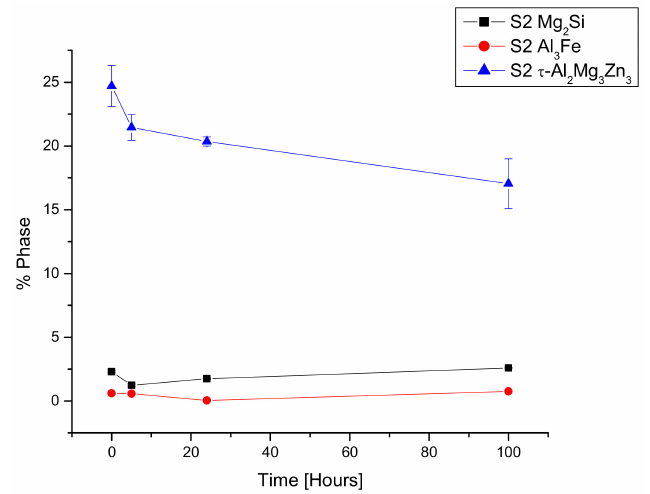
Figure 4. Phase % as a function of treatment time for samples in series 1.